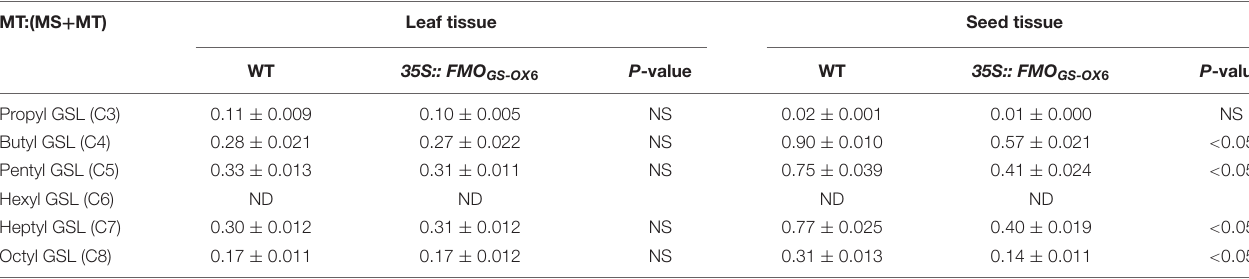
TABLE 1 | Glucosinolates profile in 35S::FMO GS - OX 6 .